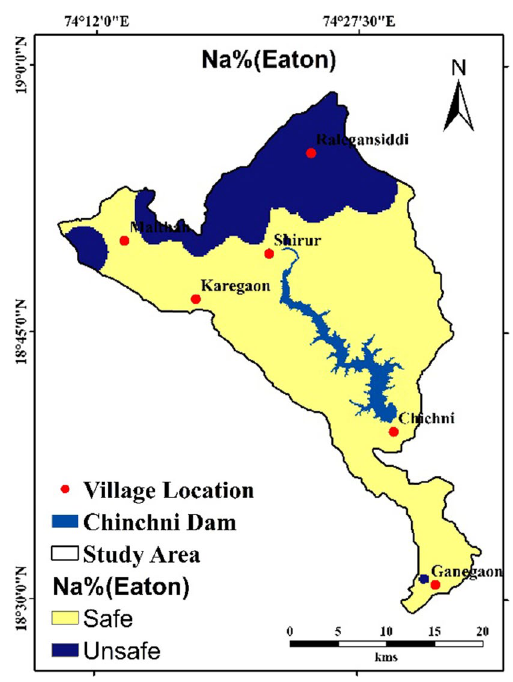
Fig. 10 Spatial variation in Na% (Eaton method)